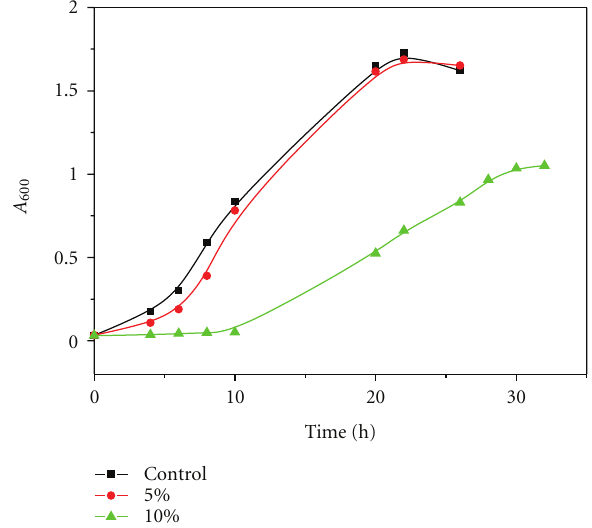
Figure 4: Growth curves of Bacillus subtilis in a medium with varying percentage of GC (%